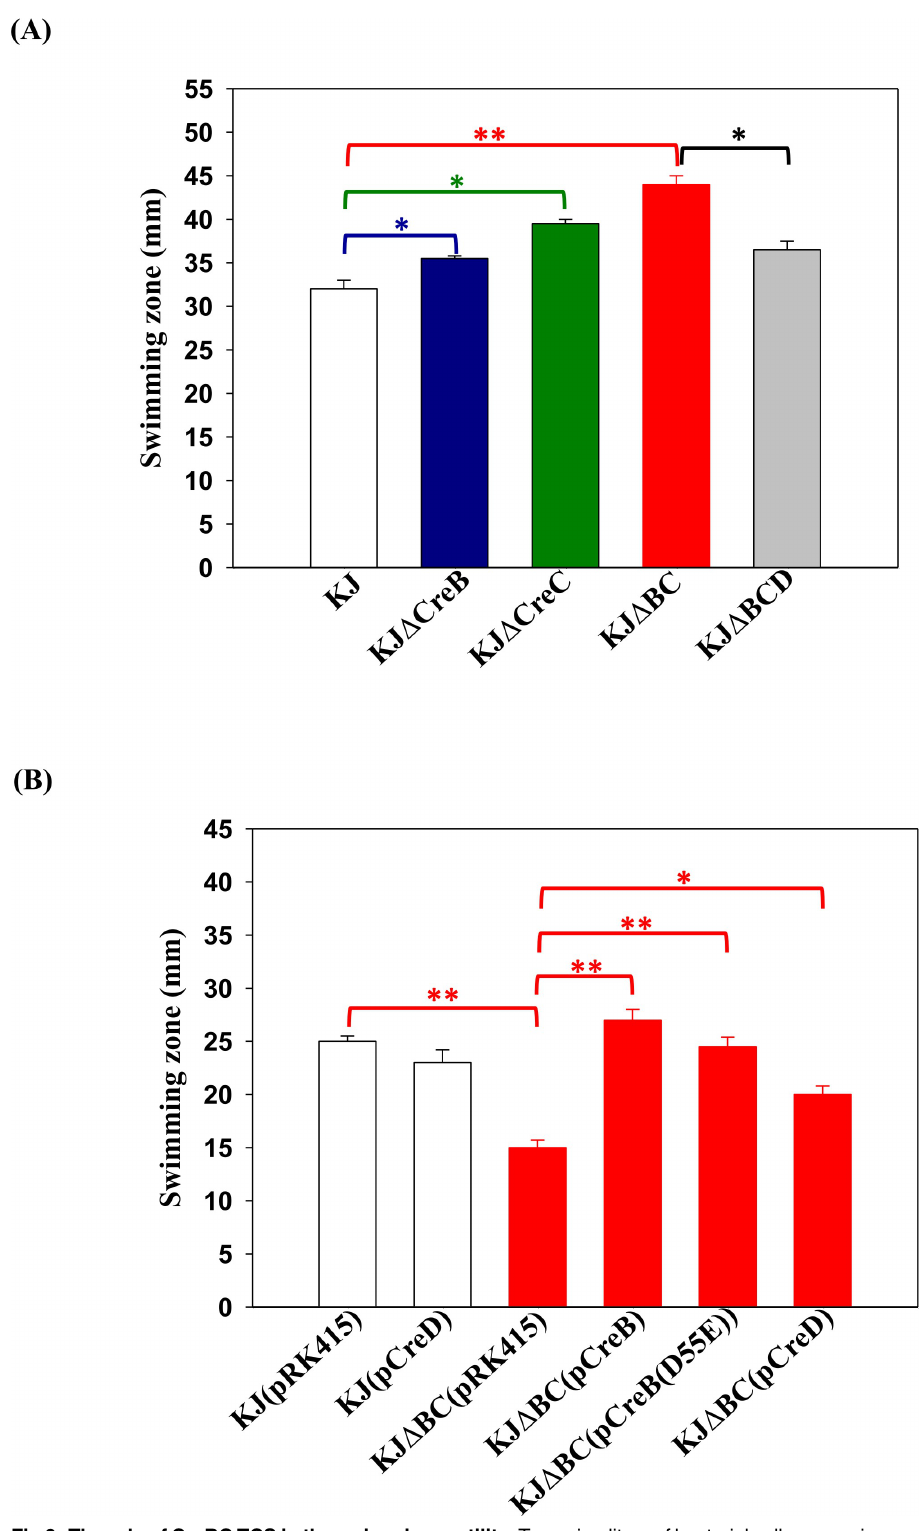
Fig 3. The role of CreBC TCS in the swimming motility. Two microliters of bacterial cell suspensionwas inoculated onto the swimmingagar (1% tryptone, 0.5% NaCl, and 0.15% agar). Results were expressedas diameters (millimetres) of swimmingzones after 48 h of incubation at 37˚C. Data representthe means from 3